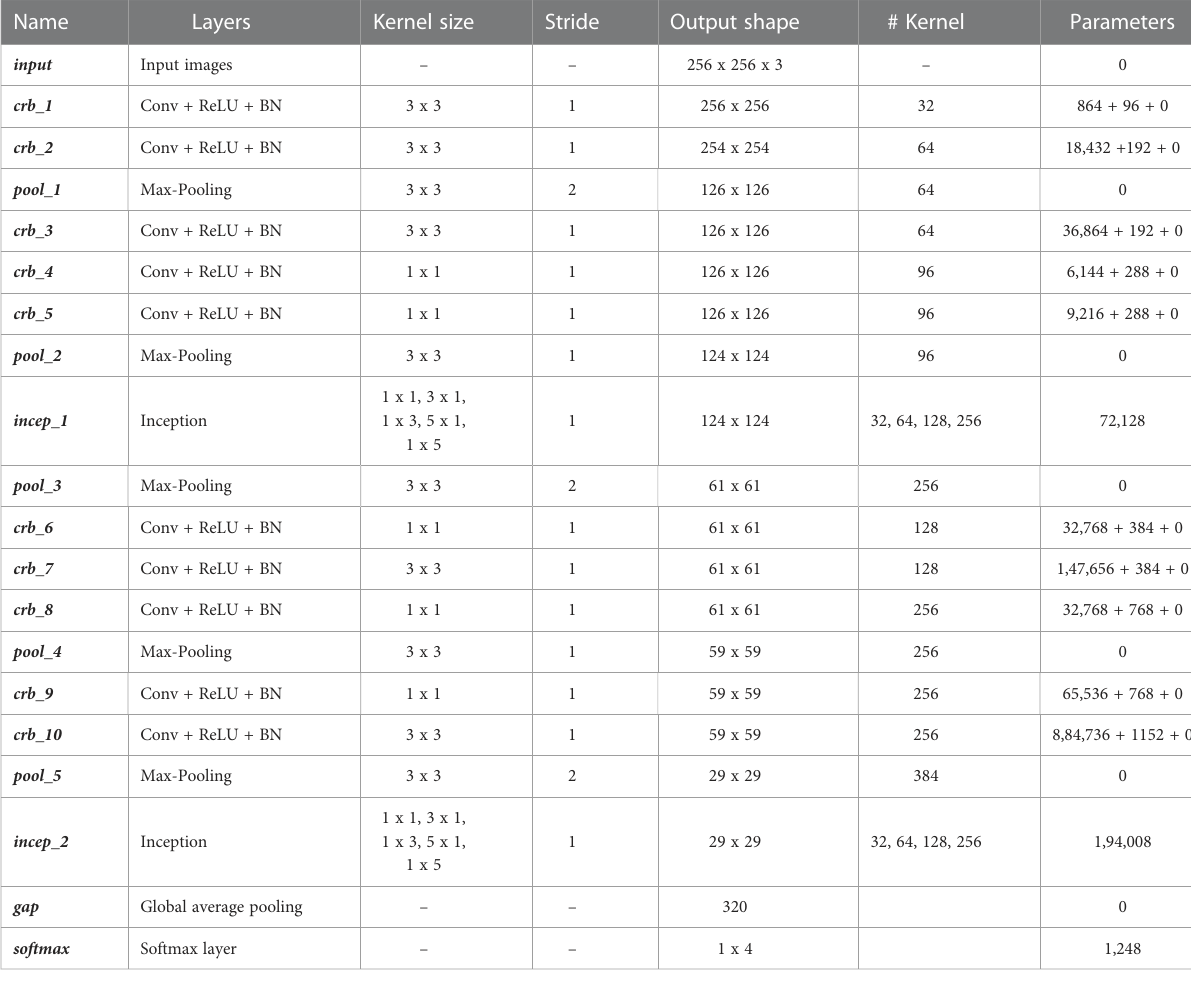
TABLE 3 Layer-wise con fi guration of the proposed